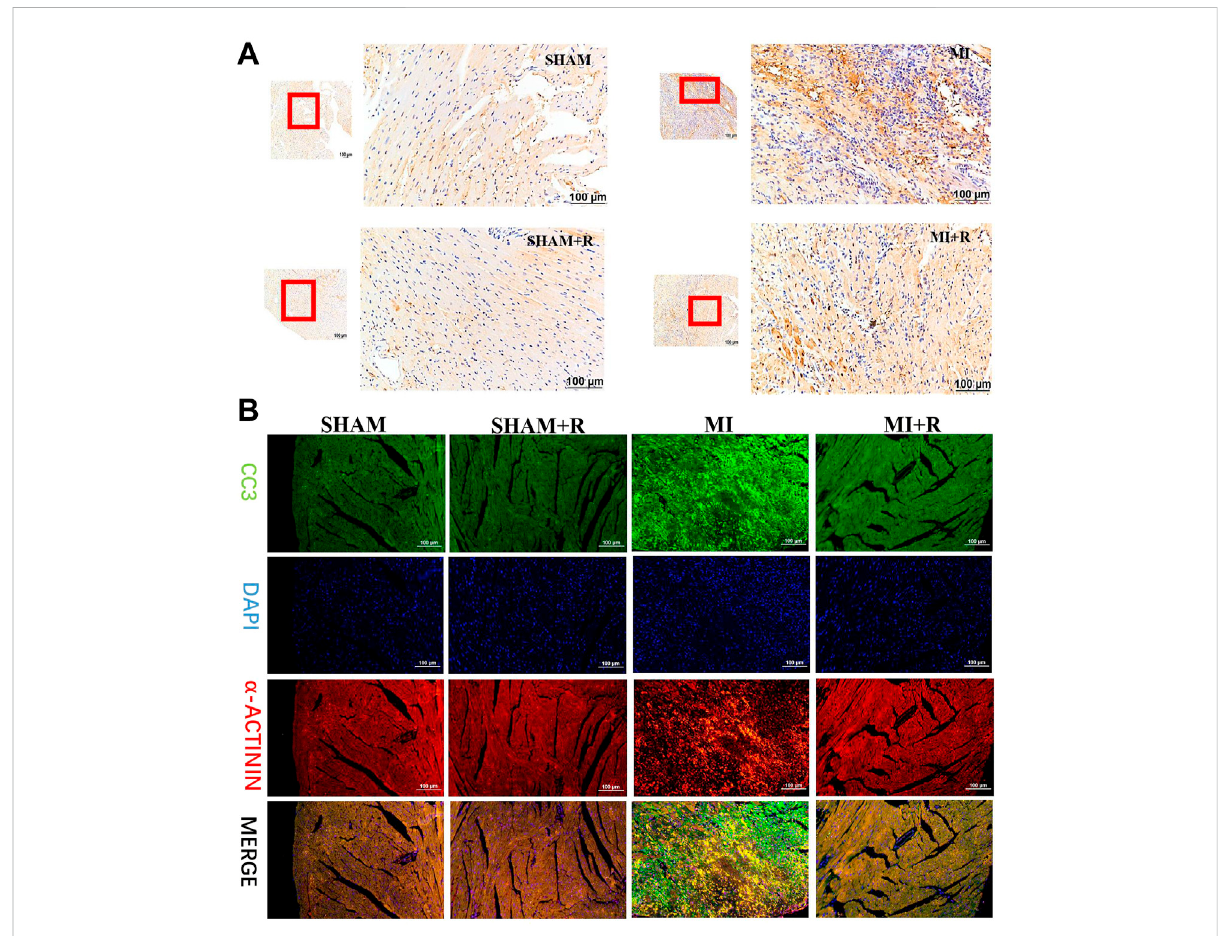
FIGURE 6 RSYRD can reduce the expression of CC3 in the myocardial tissue 3 days after MI. (A) IHC staining for CC3 in myocardial tissue of mice in four groups. (B) IF staining for CC3 in myocardial tissue of mice in four groups. Scale bars: 100 μ